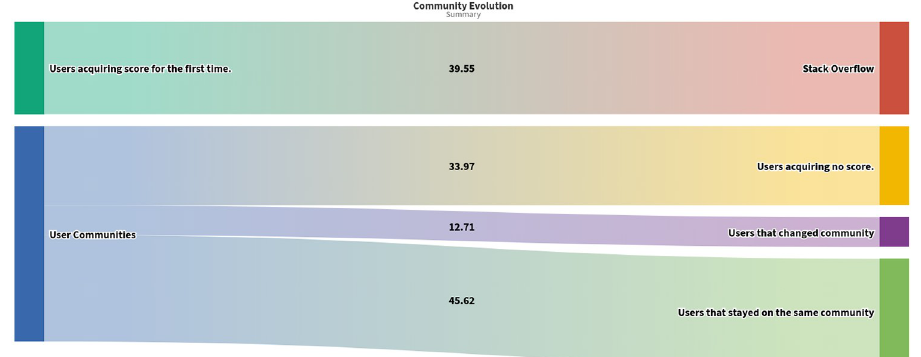
inactive (i.e. do not acquire any score on the next year), migrate to another community within the platform, or stay in the same community in consecutive years.